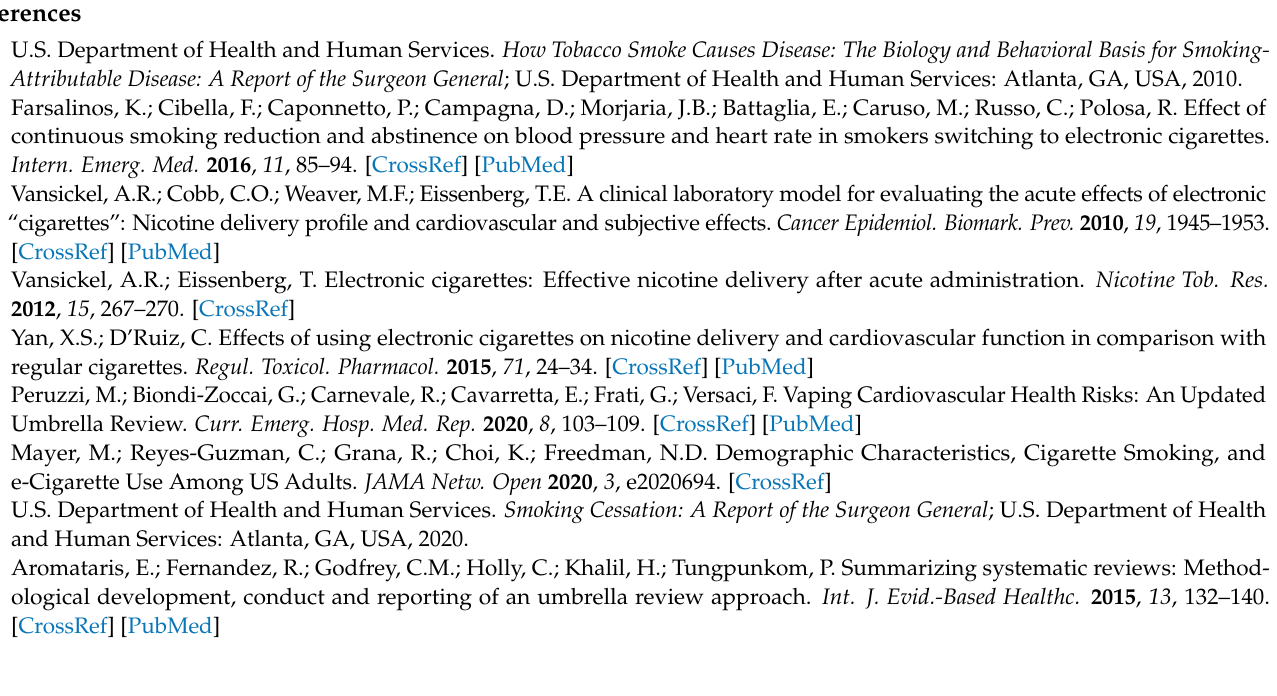
database; Table S1: List of excluded non-systematic literature reviews with relevant health outcomes; Table S2: Systematic reviews, meta-analyses, and included health outcome domains; Table S3: Included systematic reviews- extended table with results, conclusions and